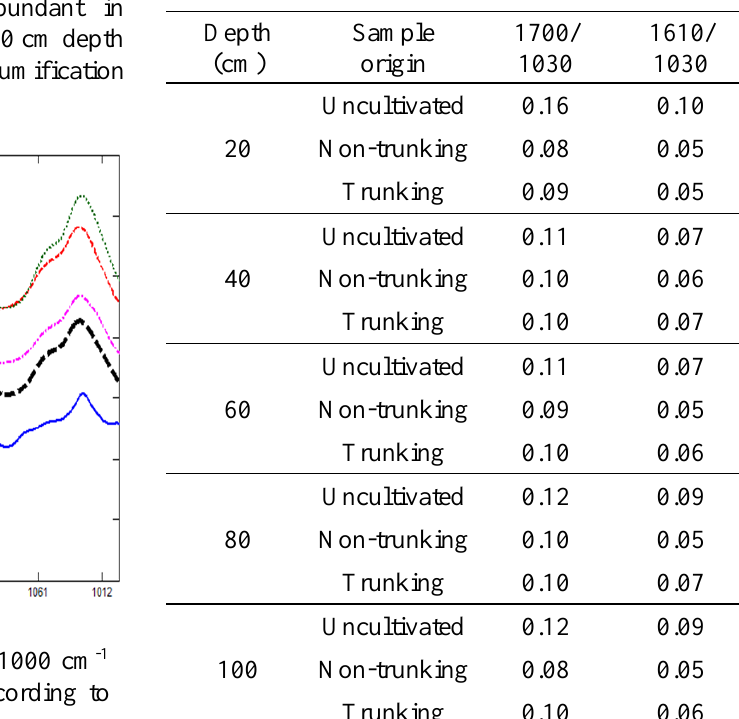
Table 1. The ratio intensities of 1700/1030 and 1610/1030 for uncultivated and cultivated peat, according to